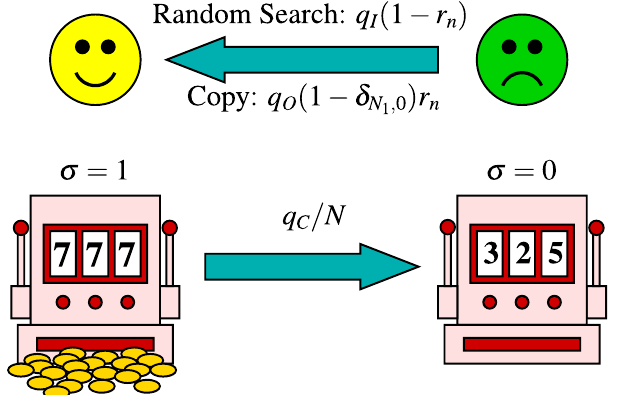
Figure 1. An agent and an rMAB. The number of agents who know a good arm is denoted as N 1